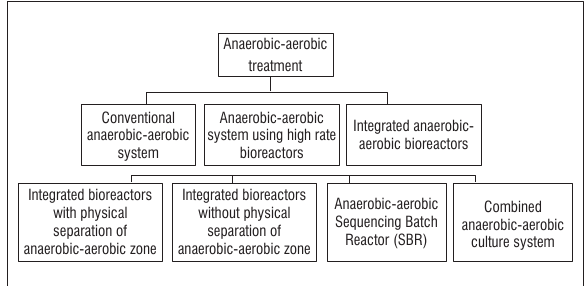
Figure 2: Combined aerobic and anaerobic systems used in the treat- ment of